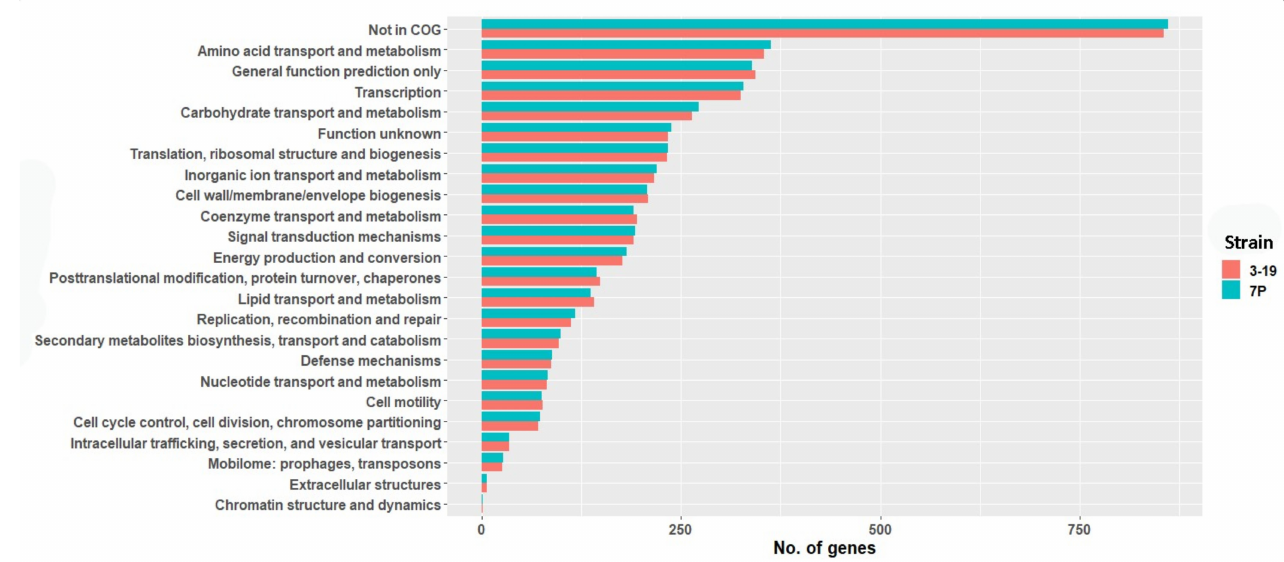
Figure 3. Comparative analysis of COG categories between 3-19 and 7P